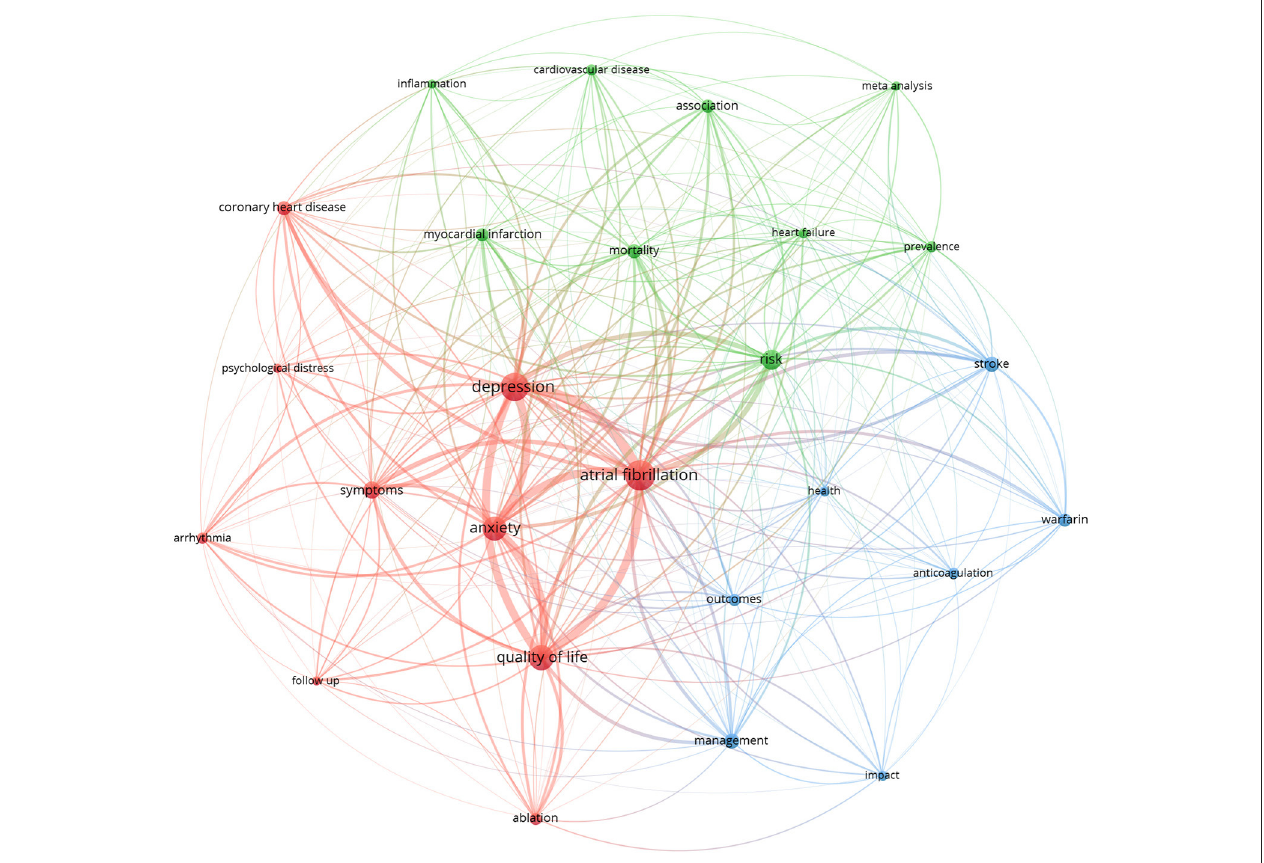
FIGURE 6 | The network visualization of keywords. The size of each circle represents the weight of a keyword. The distance between two circles indicates the relatedness between two circles. The stronger the relatedness, the shorter the distance. The color of the circles represents the respective cluster